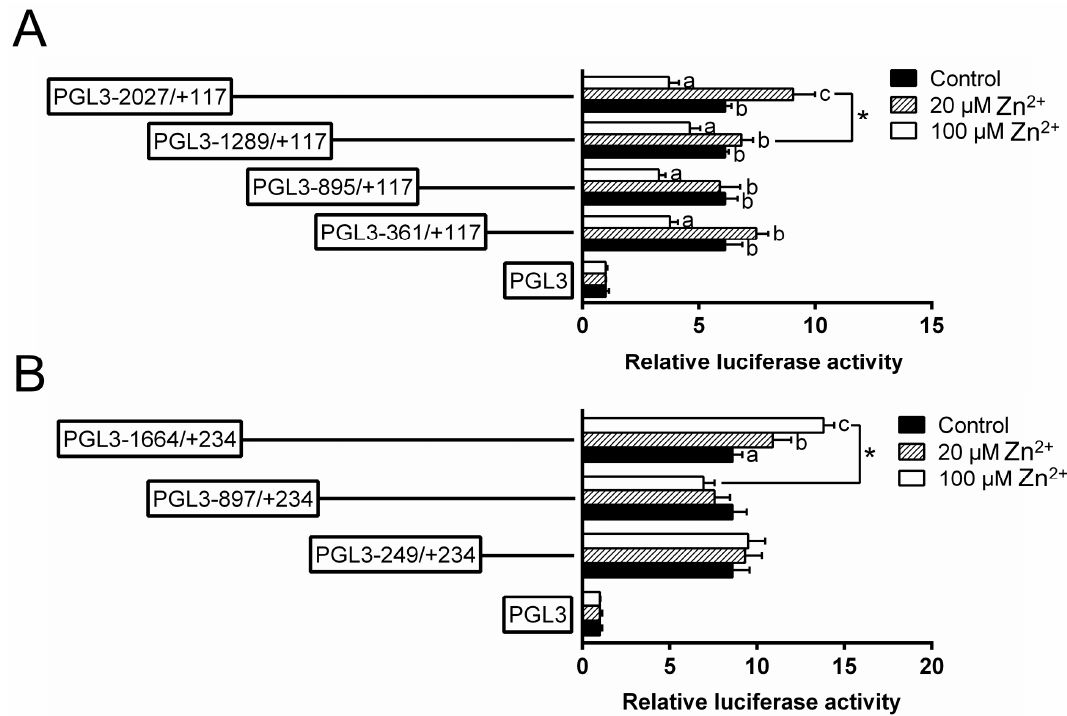
Figure 3. 5 ′ unidirectional deletion assays for promoter regions of ZIP3 ( A ) and ZIP8 ( B ) after Zn incubation. Values showed the ratio of activities of Firefly to Renilla luciferase, normalized to the control, and were presented as mean ± SEM ( n = 3). Asterisk (*) indicates significant differences between different 5 ′ unidirectional deletion plasmids under the same treatment ( p < 0.05). Different letters (a, b and c) indicate significant differences among different treatments in the same plasmid ( p < 0.05).